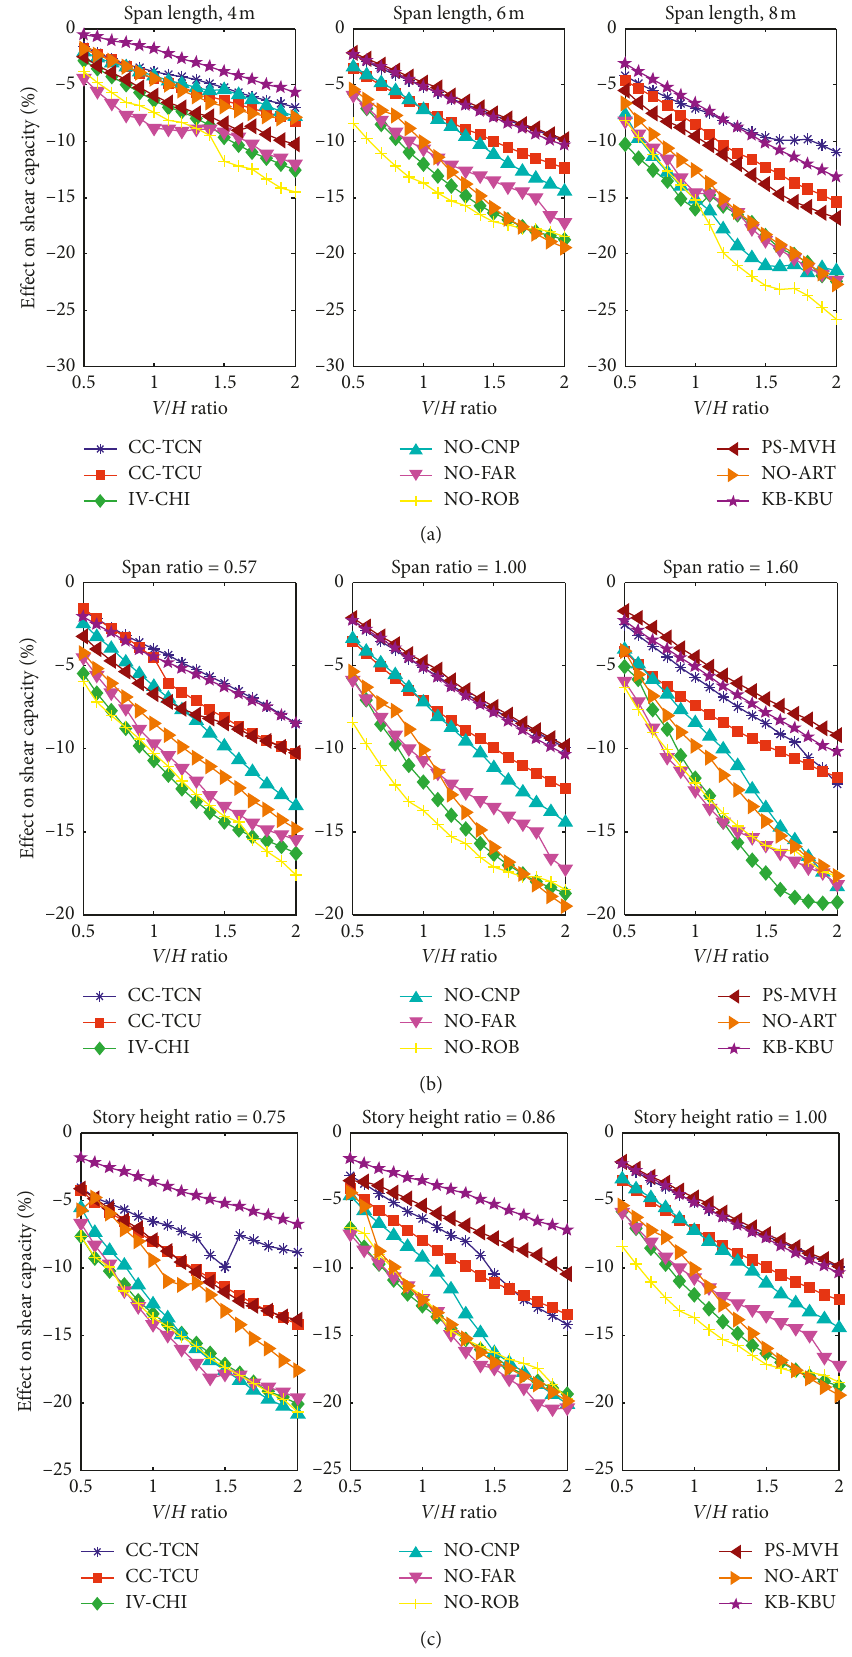
Figure 10: Effect on shear capacity, ACI318-14: (a) span length, (b) span ratio, and (c) storey height